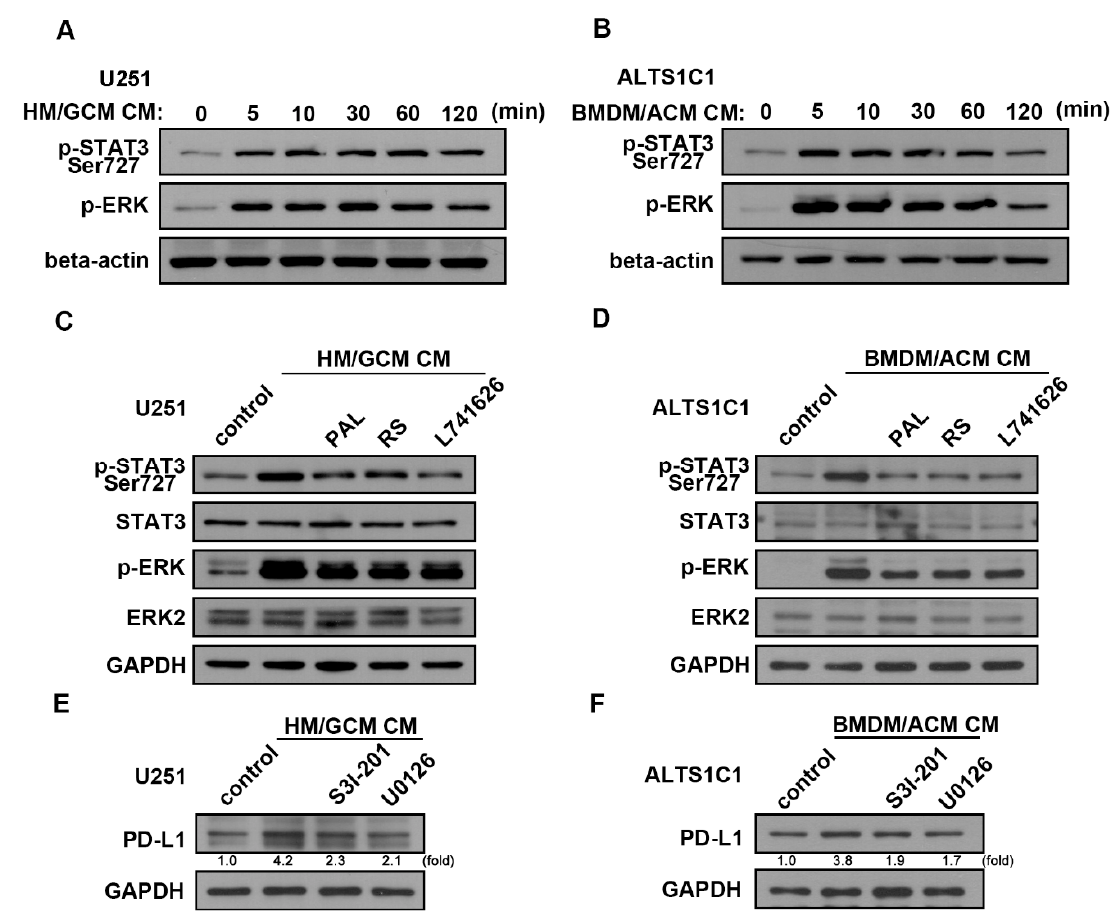
Figure 6. ERK and STAT3 signaling pathways are involved in the interaction of GBM-macrophage-induced PD-L1 expression in GBMs. Human U251 ( A ) and mouse ALTS1C1 ( B ) GBM were incubated with HM/GCM CM or BMDM/ACM CM for the indicated time periods (5, 10, 30, 60, or 120 min). Human U251 ( C ) and mouse ALTS1C1 ( D ) GBM were treated with PAL (20 µ M), RS (20 µ M), or L741626 (1 µ M) and incubated with HM/GCM CM or BMDM/ACM CM. Phosphorylated-STAT3 and phosphorylated ERK expressions were determined by using Western blot analysis. Human U251 ( E ) and mouse ALTS1C1 ( F ) GBM were treated with S31-201 (30 µ M) or U0126 (1 µ M) and incubated with HM/GCM CM or BMDM/ACM CM for 48 h. PD-L1 expression was determined by using Western blot analysis. ( n = 3–4).